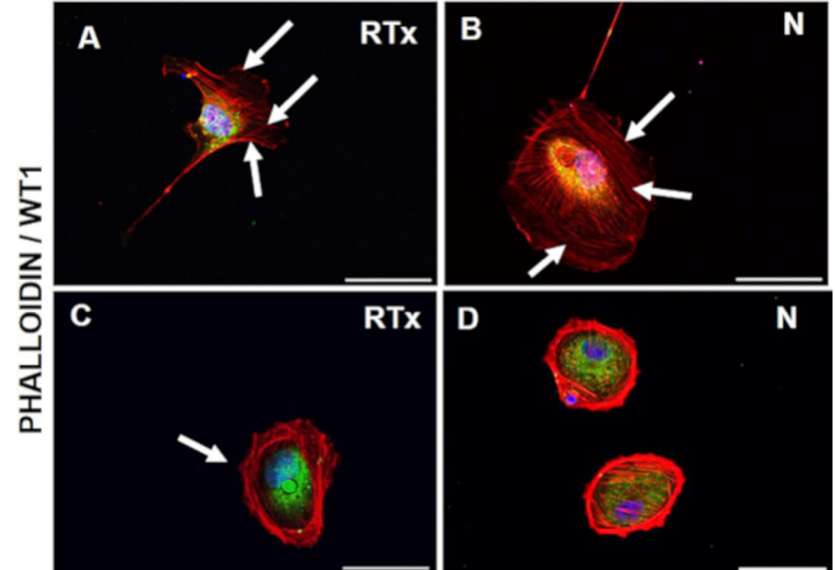
Figure 2. Cytoskeleton remodelling. Actin detected by phalloidin staining (red) shows different distribution in urinary cells of both N and RTx. WT1 nuclear staining identifies the podocytes (green); Podocyte with actin bundles aligned in the cytoplasm ( A , B ); other podocytes with altered appearances with round shapes, thickened actin bundles at the cell boundaries, and limited cytoplasmic stress fibers ( C,D ) DAPI (blue) nuclear staining shows the absence of apoptosis. Scale bar is 100 µm.